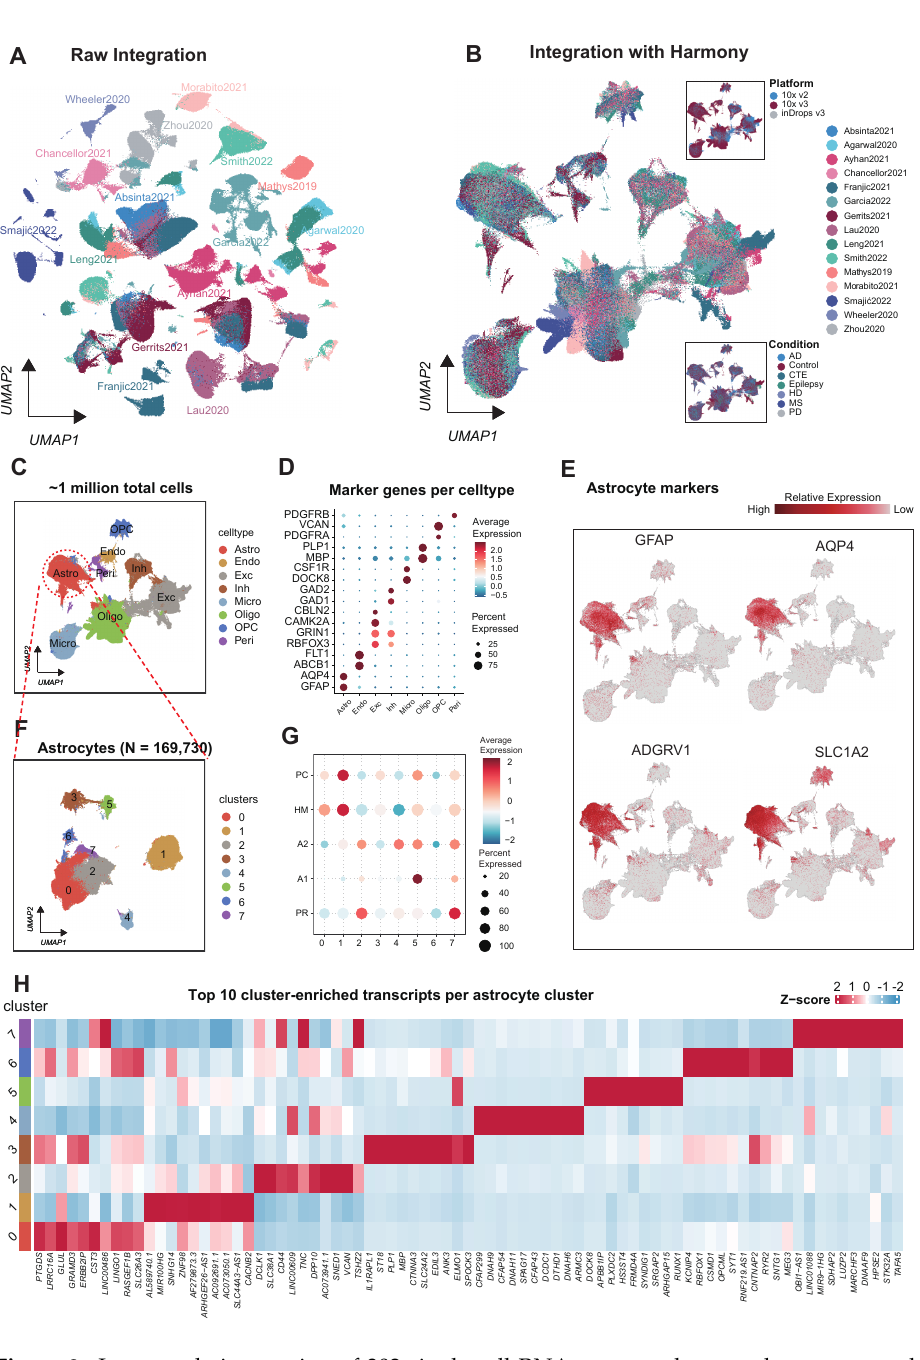
Figure 2. Large-scale integration of 302 single-cell RNA-seq samples reveals astrocyte subtypes in the human brain. ( A ) UMAP plot of the combined datasets before batch correction, colored by dataset source. ( B ) UMAP plot of integrated dataset after batch correction with Harmony, colored by dataset source. The corner insets are colored by scRNA-seq platforms (up) and disease types (down). ( C ) UMAP plot colored by major cell types in the human brain. ( D ) Expression of canonical marker genes of major cell types. Dot plot showing the expression level (color scale) and the percent of cells expressing (dot size) marker genes across cell types. ( E ) UMAP plots of all cells colored by expression levels of four classical astrocyte markers. ( F ) A total of 169,730 astrocytes were re-clustered into 8 astrocyte subtypes (cluster 0 − 7). ( G ) General characteristics of 8 subtypes using relative expression strength of 5 known astrocyte programs: phagocytosis (PC); homeostasis (HM); A1 − and A2 − reactive astrocytes (A1, A2); and pan-reactive astrocytes (PR). ( H ) Heatmap showing the normalized average expression of the top 10 enriched genes for each